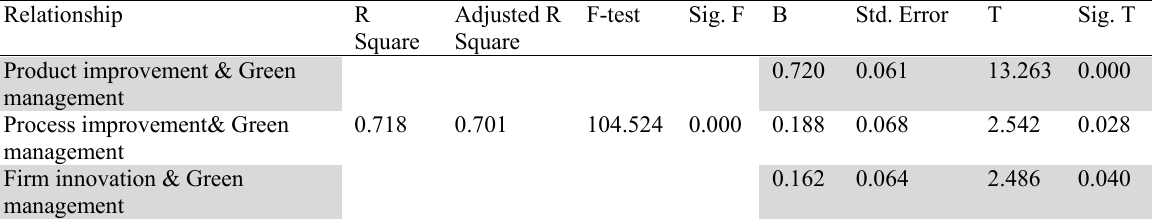
Summarized Full Regression between Dependent variable and independent variable